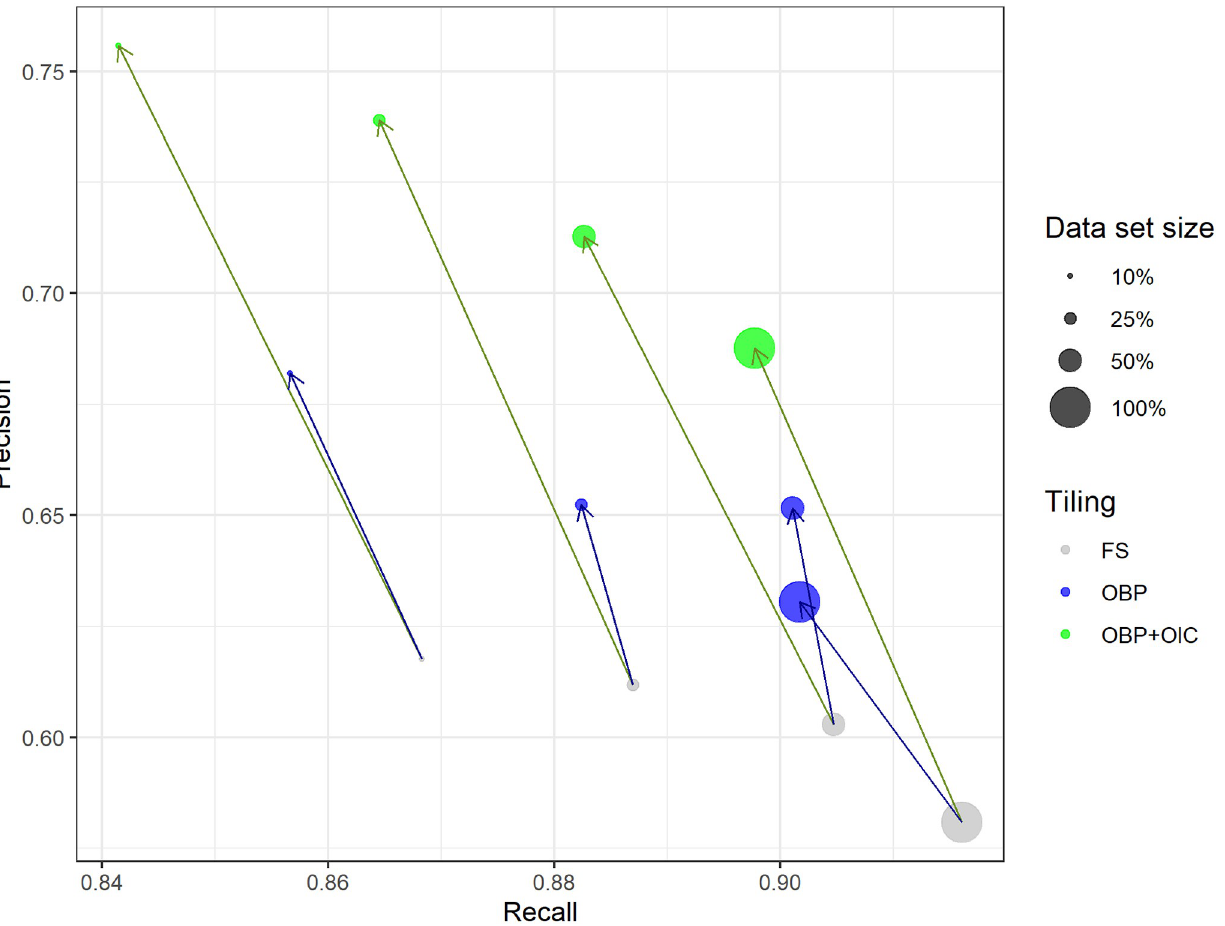
Fig 6. Effect of training data set size and tiling method on segmentation performance for Mask R-CNN models with prediction threshold 0.95, average over six different virtual slides. Blue arrows indicate shift from fixed-stride to object-based tile positioning, green arrows indicate shift to object- based positioning + object integrity constraint. FS = fixed-stride, OBP = object-based positioning, OBP+OIC = object-based positioning + object integrity constraint. Please note the different axis scalings, i.e., that substantial improvements in precision with the object-based tiling schemes are usually associated with relatively much smaller decreases in